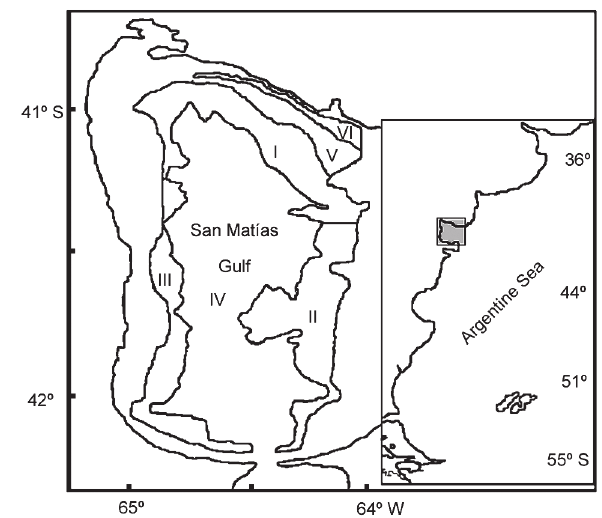
Fig. 1. Study area and design of bottom trawl surveys. Strata I, II, and III: 90-130 m; stratum IV: >130 m; stratum V: 50-89 m and stratum VI: 20-49